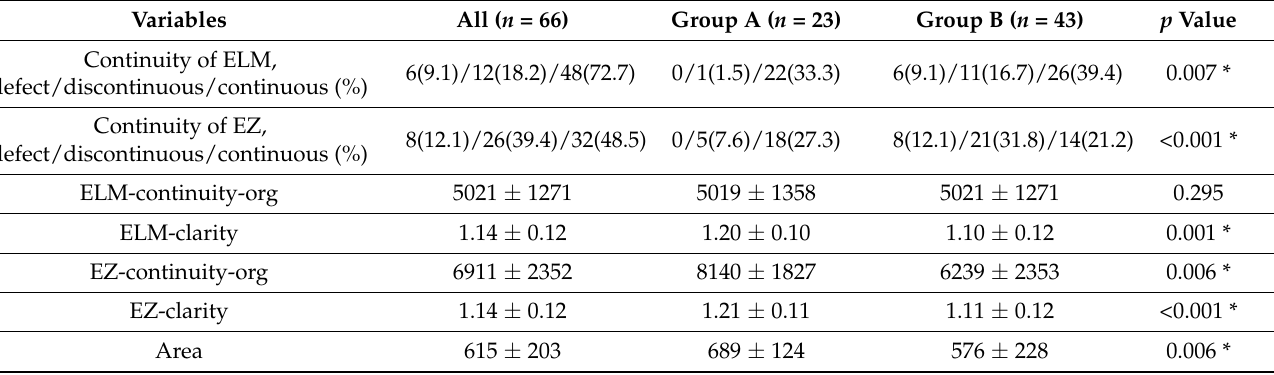
Table 2. Features of trimming image at the first resolution of ME.